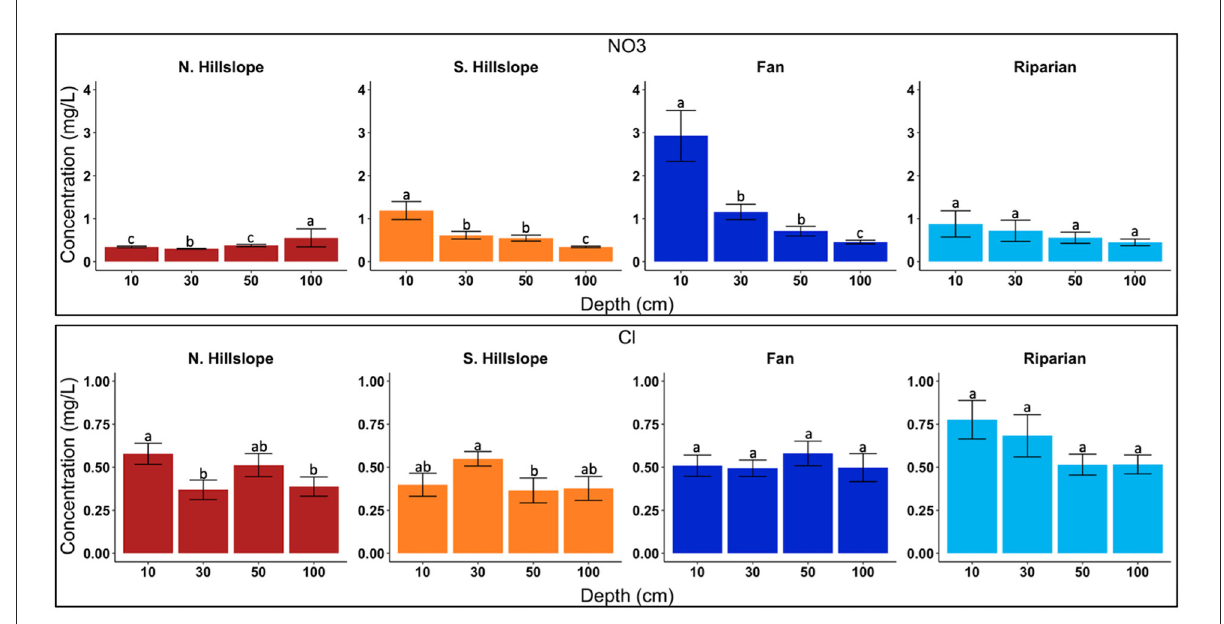
FIGURE3 Bar charts displaying anion concentrations across sampled depths. Letters denote significance among depths at p < 0.05. Data presented are limited to solutes which were used for molar ratio comparisons with stream samples.